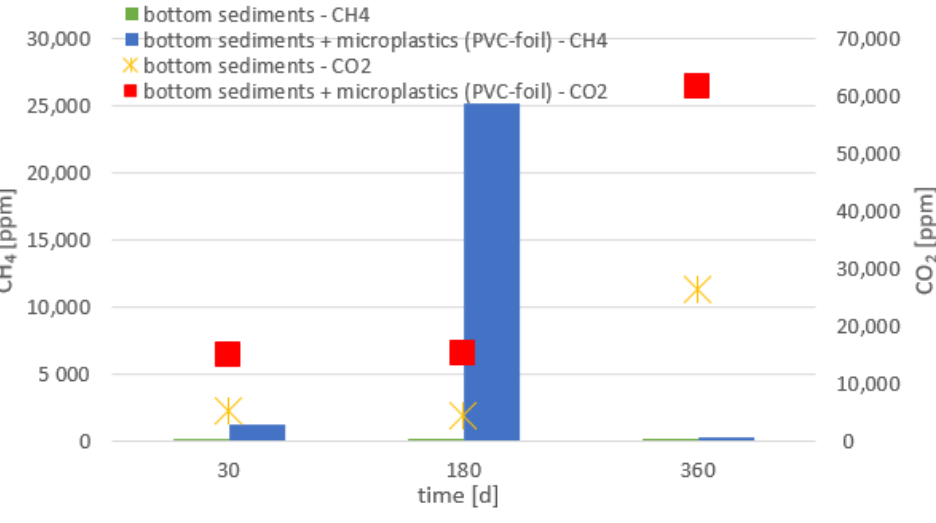
Figure 3. CH 4 and CO 2 emissions from PVC